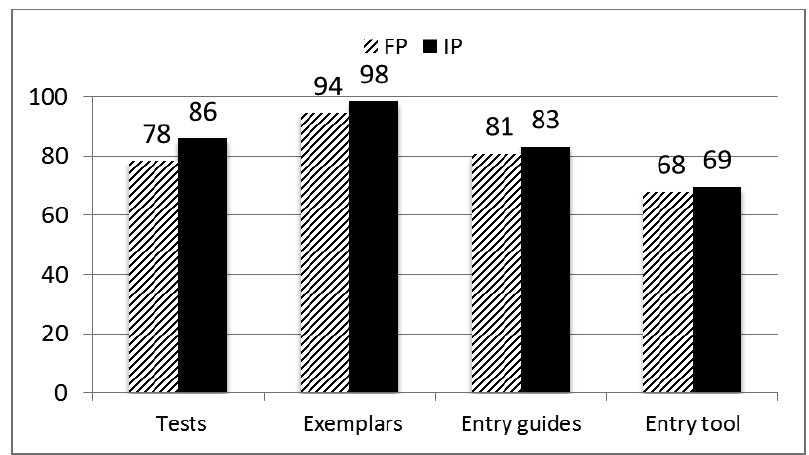
Figure 1: Receipt of relevant ANA